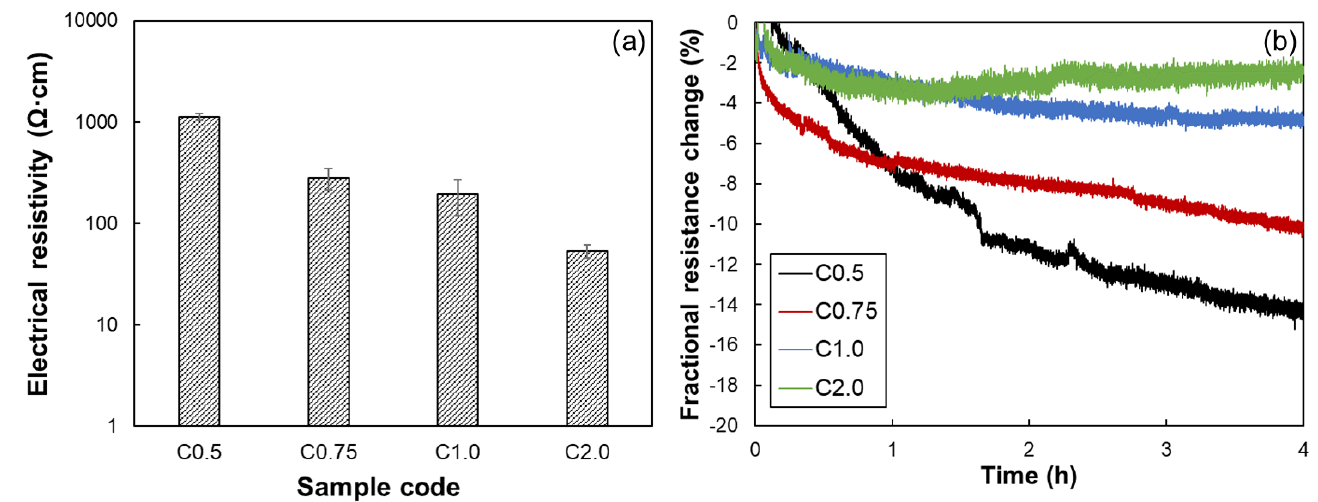
Figure 3. ( a ) Electrical resistivity and ( b ) tunneling-induced electrical stability of samples.